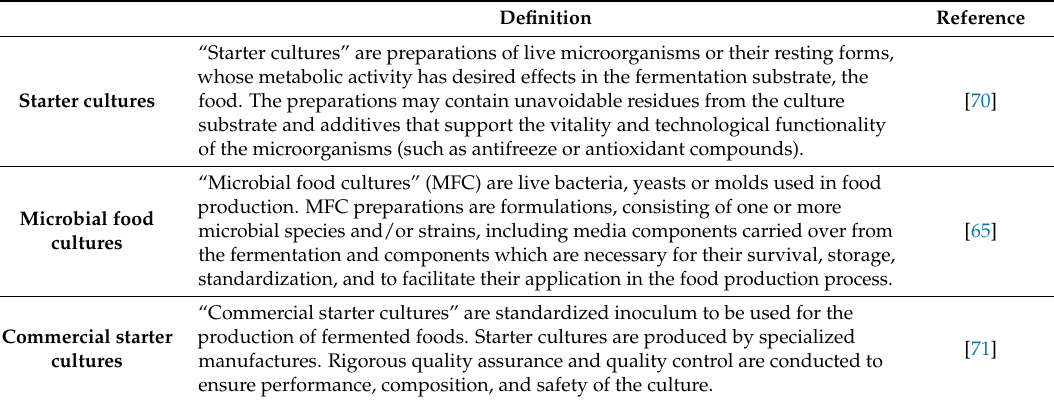
Table 5. A selection of definitions for “starter cultures” reported in recent scientific publications.